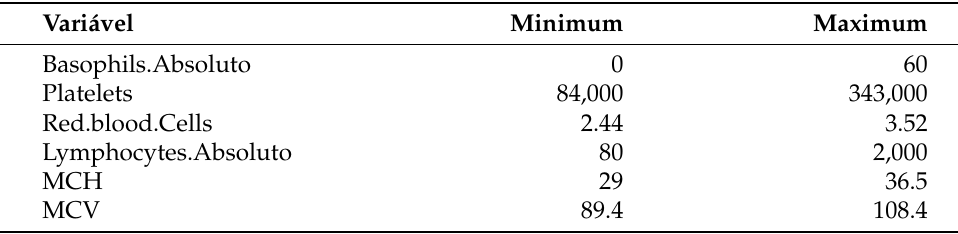
Table 13. Minima and maxima of the variables found for Neuron 4, level 3 TESSOM .